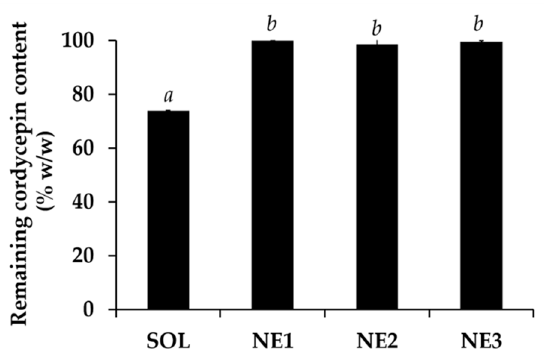
Figure 13. The remaining cordycepin content in CW solution in buffer pH 5.5 (SOL) and nanoemulsions containing various content of Tween ® 85, including 5% w/w (NE1), 10% w/w (NE2), and 15% w/w (NE3), after 8 cycles of heating-cooling condition. The letters a and b denoted significant difference between different formulations analyzed using one-way ANOVA with post-hoc Tukey test ( p < 0.05).